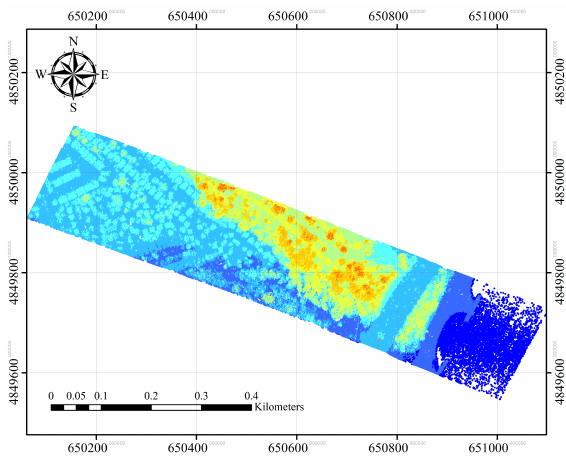
Figure. 1 Titan Multispectral LiDAR Scanner Data